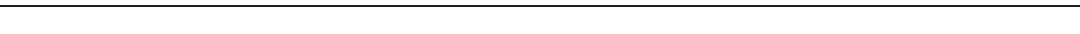
Fig. 3 Energy consumption and greenhouse gas emissions from a mid-size electric vehicle battery. a Top fi ve and bottom fi ve states on the decreasing rate of battery charging – discharging ef fi ciency, ranging from 98 to 77% during the battery life. b Top fi ve and bottom fi ve states on the increasing rate of unit energy consumption, ranging from 100 to 127% upon 30% capacity loss. c Top fi ve and bottom fi ve states on unit energy consumption of local driving, ranging between 140 kWh km − 1 in Hawaii and 207 kWh km − 1 in Alaska. d Top fi ve and bottom fi ve states on energy consumption per km highway driving, ranging between 154 kWh km − 1 in Hawaii and 205 kWh km − 1 in Alaska. e Unit GHG emissions per km driven and annual total GHG emissions from EV operations in each state, with the unit GHG emissions ranging between 0.6 g CO 2,eq km − 1 in Vermont and 167 g CO 2,eq km − 1 in Wyoming, and the annual total GHG emissions ranging between 8.5 kg in Vermont and 2570.9 kg in Indiana. AL: Alabama, AK: Alaska, AZ: Arizona, AR: Arkansas, CA: